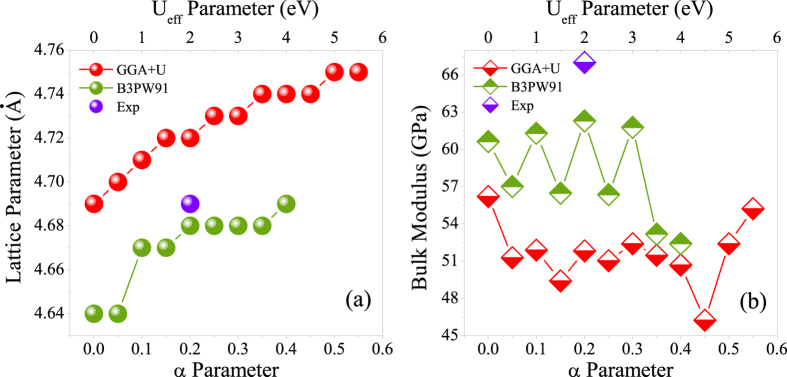
(a) Lattice parameter and (b) bulk modulus of CeIn3 in the antiferromagnetic phase as functions of Ueff parameter in GGA + U functional and α parameter in B3PW91 hybrid functional together with experimental data for comparison.